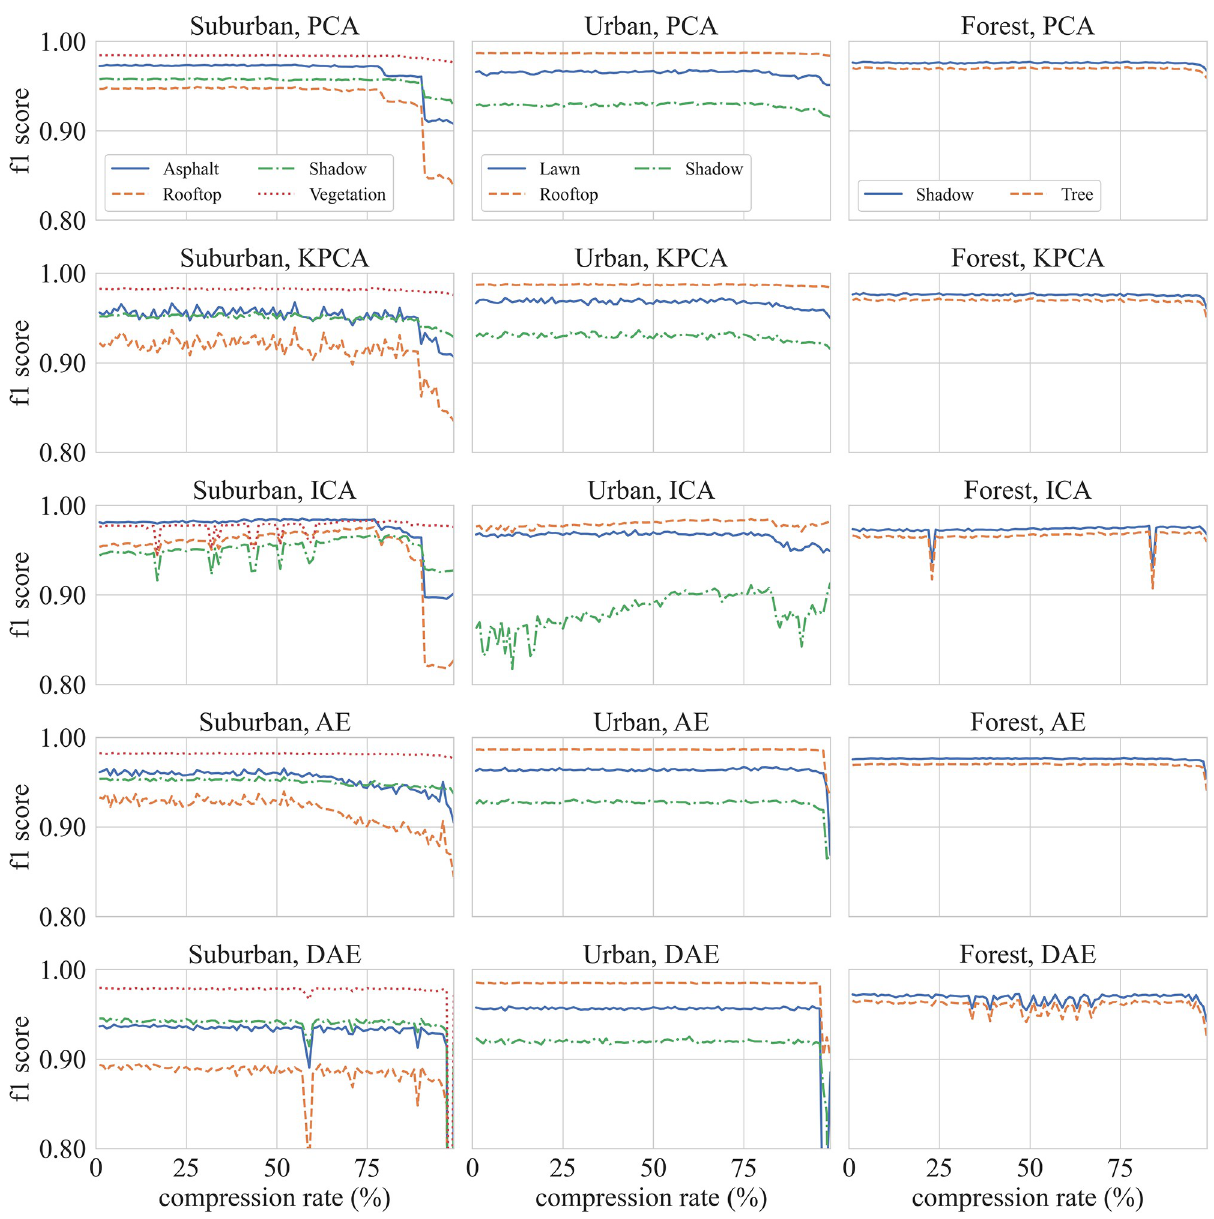
Fig 8. Classification f1 scores (using compressed data) vs. compression rates. First column plot results for the Suburban dataset, the second column plot results for the Urban dataset, and the last column plot results for the Forest dataset. The rows group the classification algorithms. The f1-scores are plotted for each label present in the